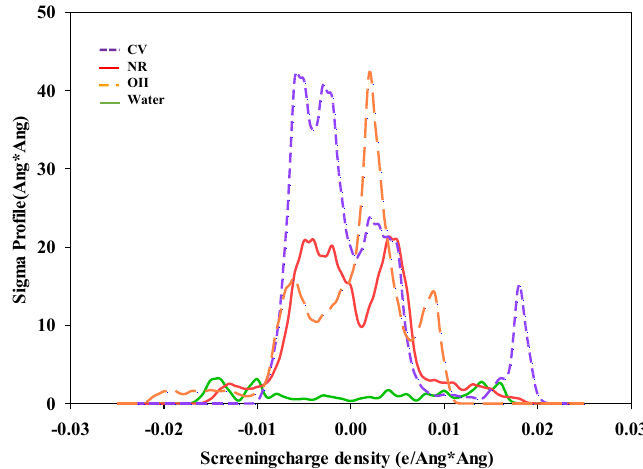
Figure 5. The obtained Sigma profile for NR, CV, OII dyes and water molecules.